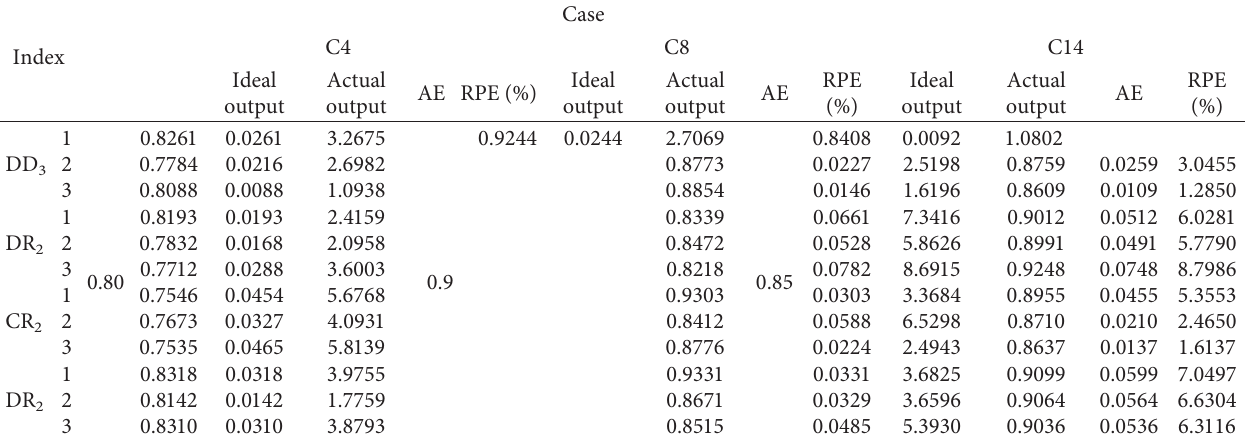
Table 4: Damage quantitative analysis comparation for DD